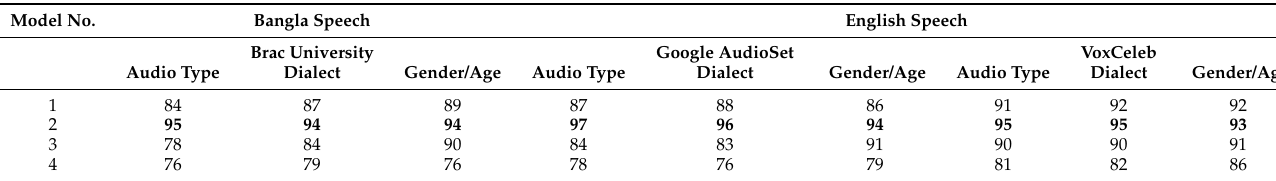
Table 9. Classification Accuracy (%) of the four different SCAE-MLELMs architecture on different datasets with input format as MFECs; Brac University previous and self-built Bangla Speech dataset and Google Audio-Set and VoxCeleb for English speech dataset is used during the experiment. Numbers in bold represent the highest classification